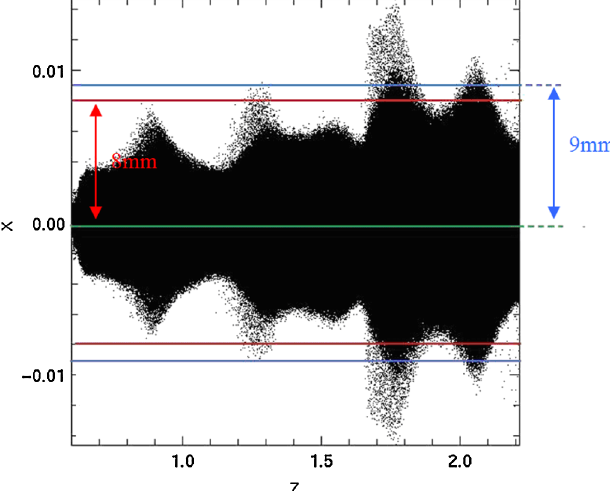
perturbations.FIG. 10. (Color) Illustration of applying two virtual conducting tubes in WARP code and the particle distribution in the X - Z plane at t ¼ 57 : 2 ns . The units of both axes are meter. The perturbation is located from 1.22 to 1.7